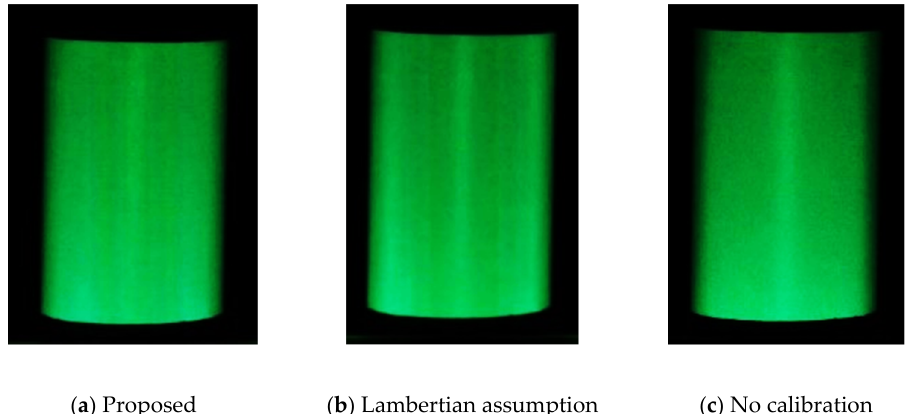
Figure 11. Comparison of visibility by green projection (open lens type).